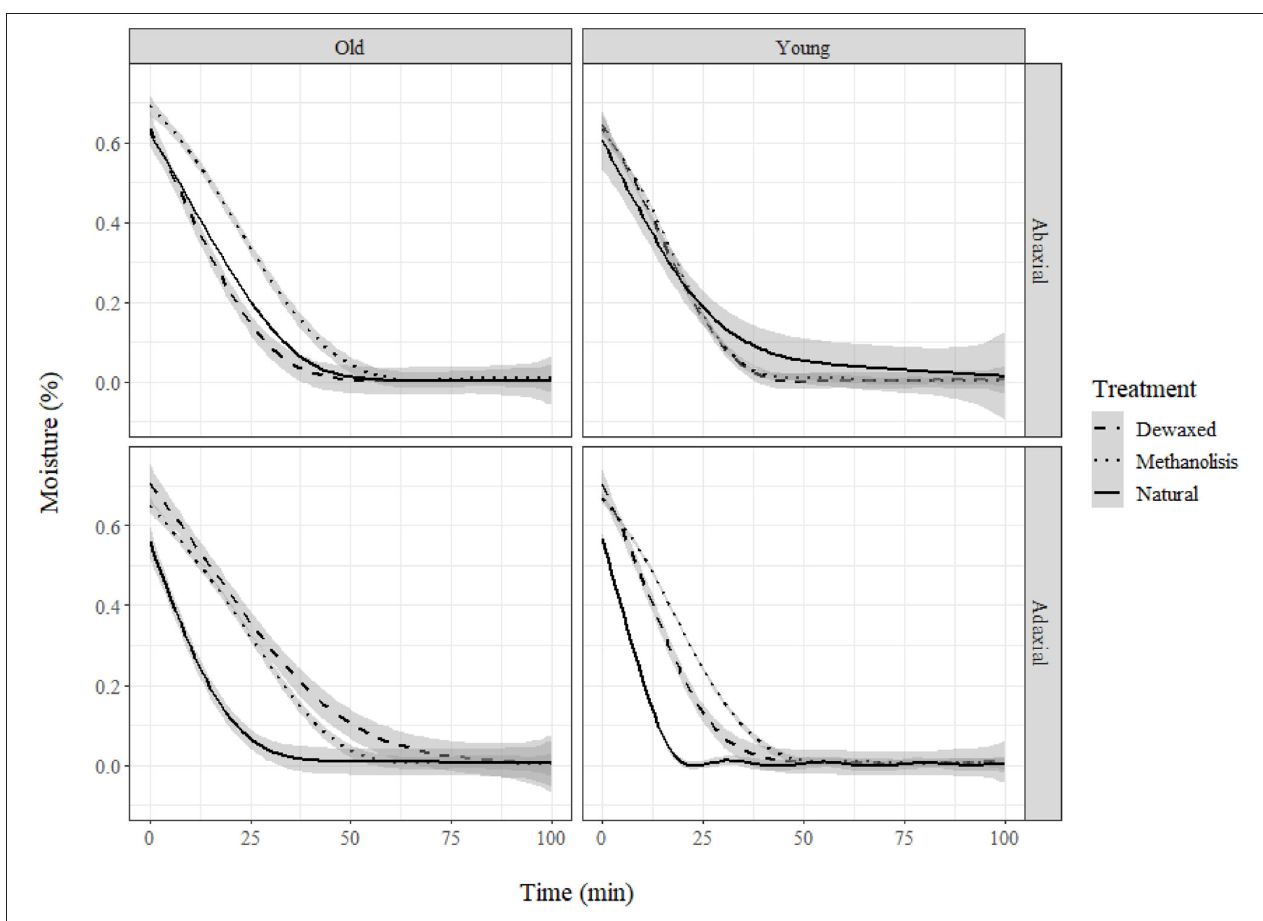
FIGURE 4 | Moisture loss (%) in holly cuticles depending on age, side, and treatment.